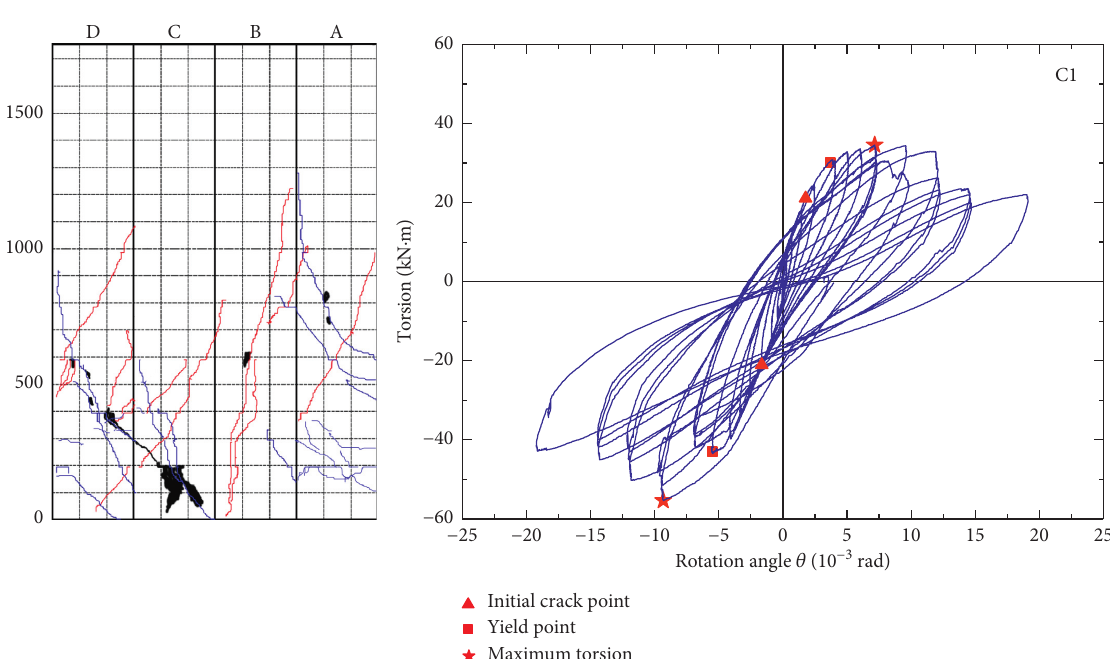
Figure 9: Damage and hysteresis curves of specimen